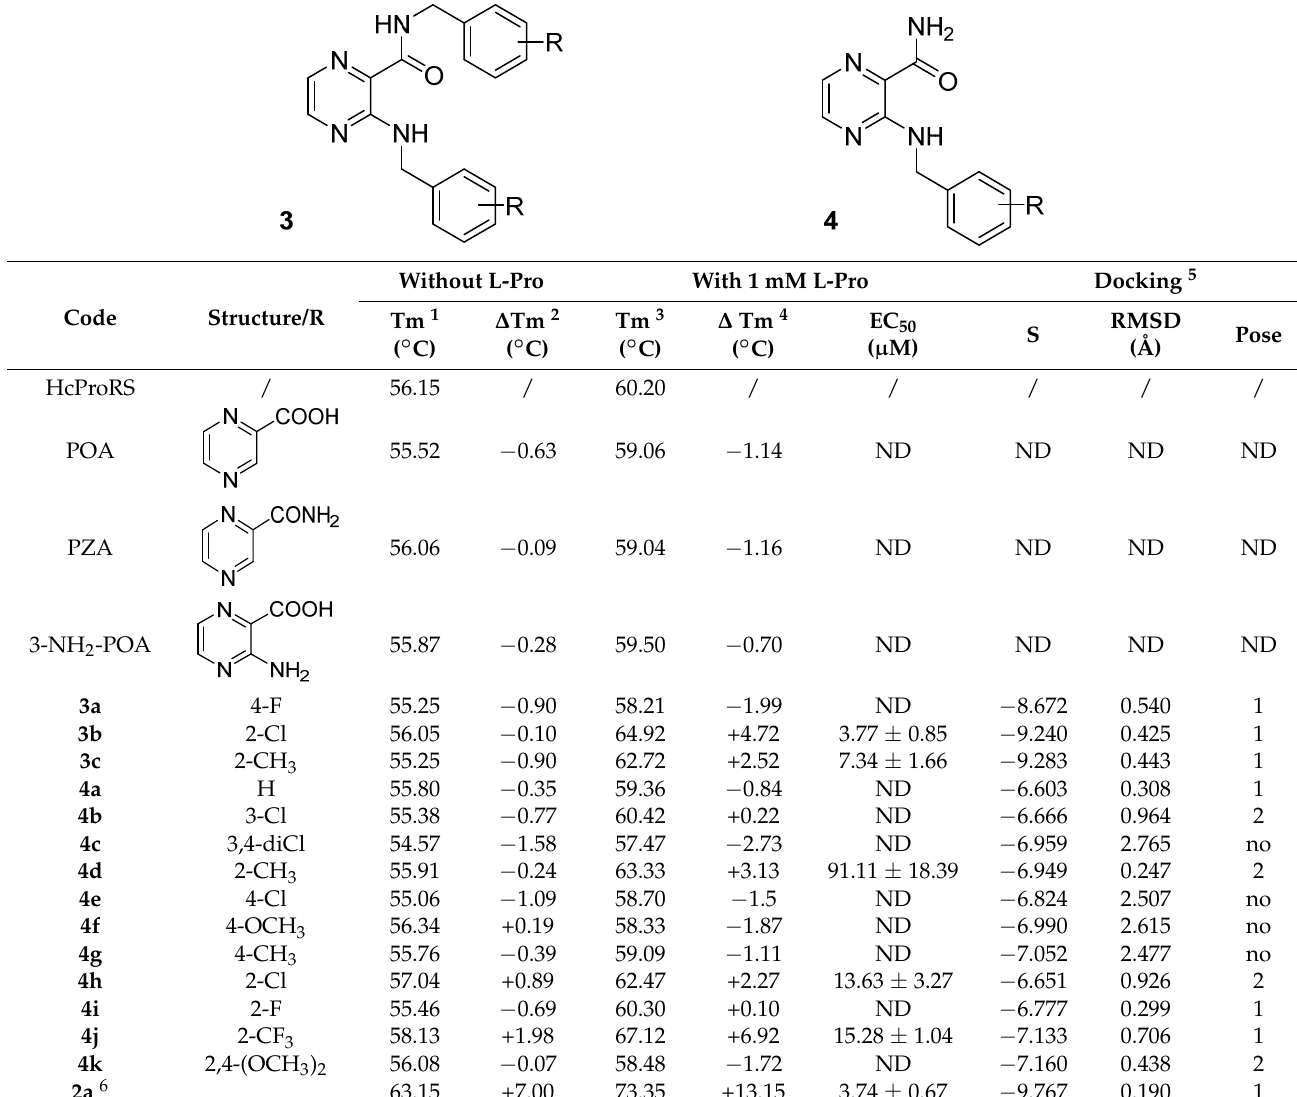
Table 1. The docking scores, thermal stabilization and EC 50 values of studied compounds.